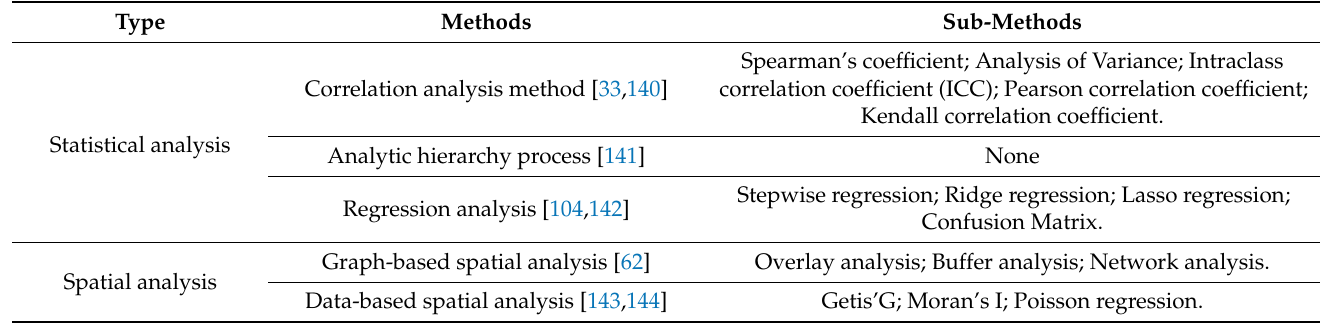
Table 6. Major elemental data analysis